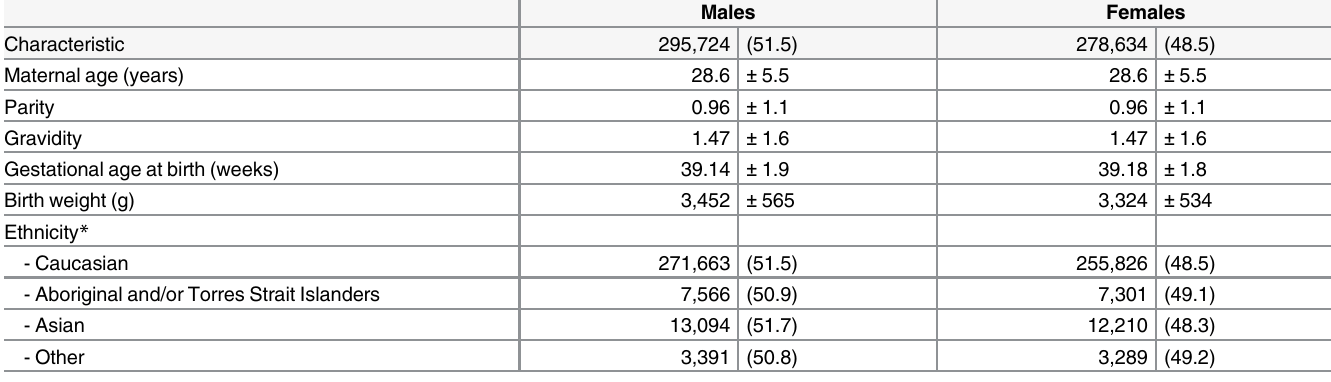
Table 1. Demographics and obstetric characteristics by fetal sex.